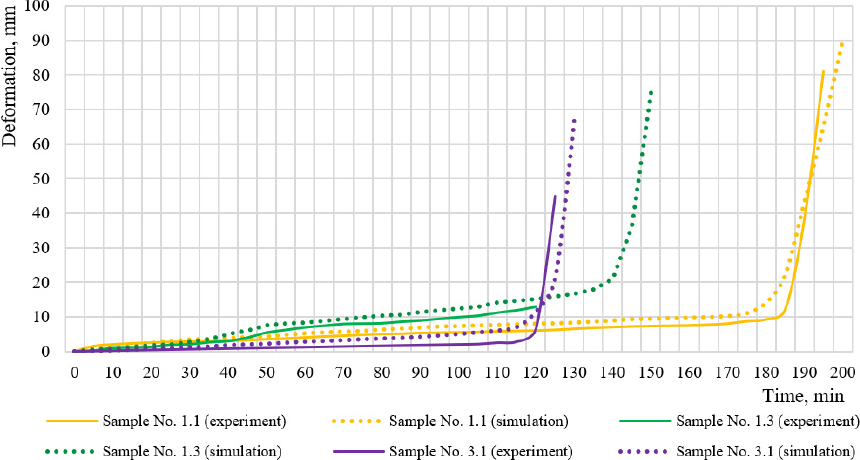
Figure 11. Experimental and calculated deformation curves of samples under the combined action of constant static and thermal loads. As seen in Figure 11, the sample with coating No. 3.1 was the first to achieve loss of bearing capacity under the combined action of thermal and mechanical loads due to the application of a larger constant static load equal to 294 kN (30 tf). According to the exper- iment, the test of the sample with coating No. 1.3 was stopped at the 123rd minute of fire exposure, and the limiting condition of the load-bearing capacity of the structure (R) was not reached by the test sample, and the vertical deformation was 13.2 mm. A time taken to reach the limit state as a reaction of the deformation growth rate of more than 10 mm/minute and the appearance of the limit vertical deformation (36 mm) at 145 min was predicted for the sample as a result of simulation. The achievement of the limit state for bearing capacity of the sample with coating No. 1.3, subjected to a hydrocarbon fire re- gime, was achieved faster in comparison to sample with coating No. 1.1, subjected to the standard fire regime.